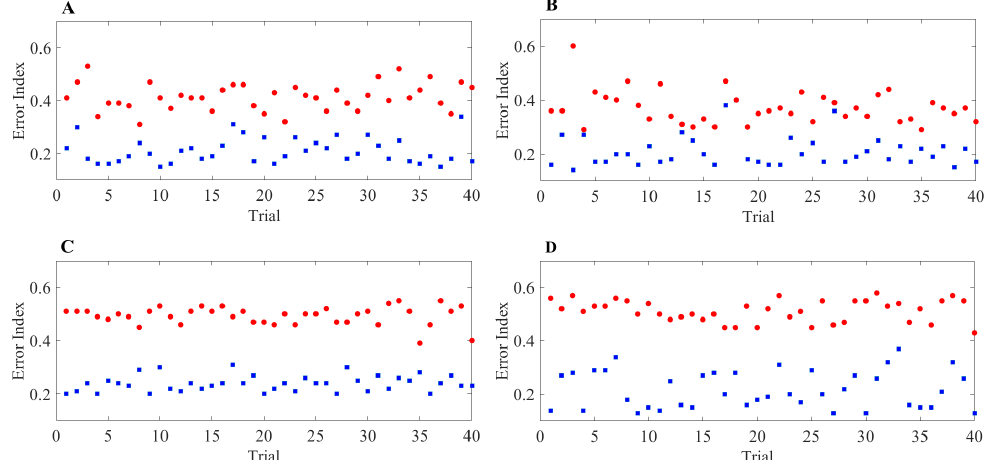
Figure 16. Error index values for 40 model TC neurons with heterogeneous TC parameter values. All baseline values of the TC parameter are given in Appendix A. ( A ) TC 1 heterogeneous error index values without stimulation (red) and with acDBS, Equation (16) (blue). ( B ) TC 2 heterogeneous error index values without stimulation (red) and with acDBS (blue). ( C ) TC 1 heterogeneous error index values without stimulation (red) and with acLFPDBS, Equation (19) (blue). D TC 2 heterogeneous error index values without stimulation (red) and with aLFPDBS